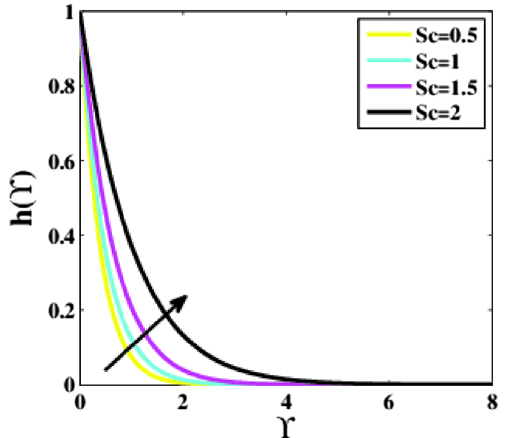
Figure 8. Plots of h (ϒ) for Sc .